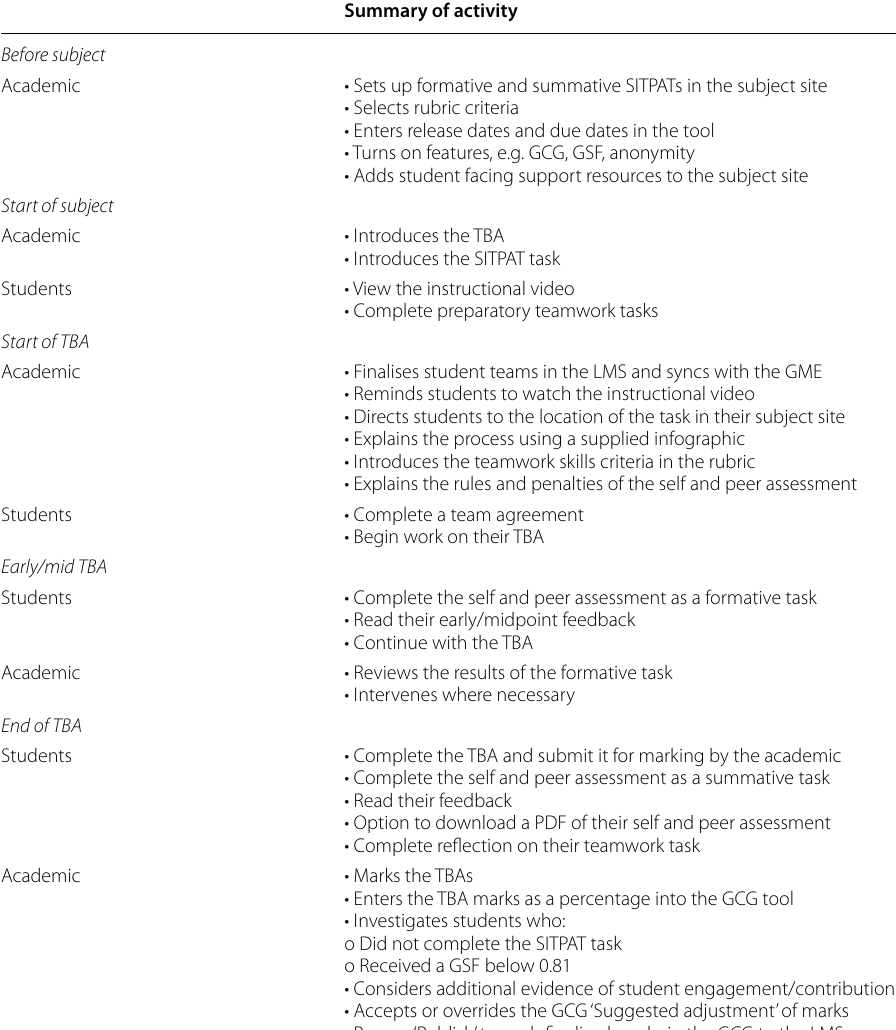
Table 3 The sequence of activities required of the academic and students to complete the TBA and SITPAT